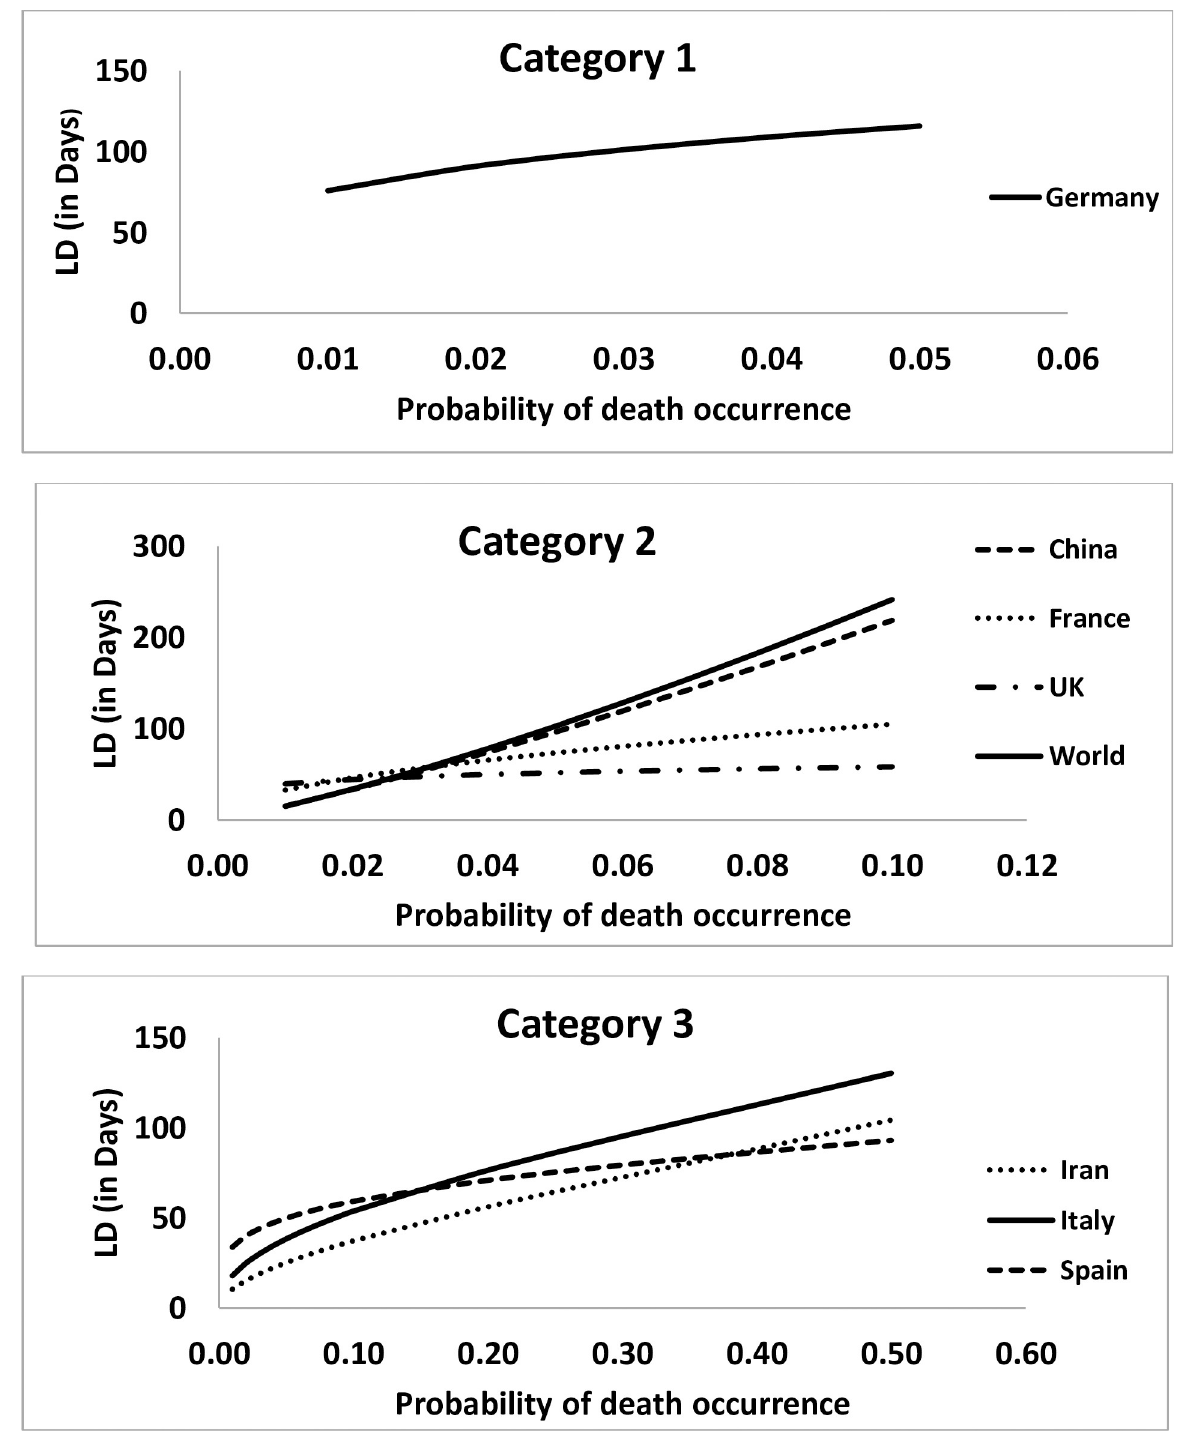
Fig 1. Pattern of lethal duration of exposure to COVID-19due to probability of deaths in different categories of countries.